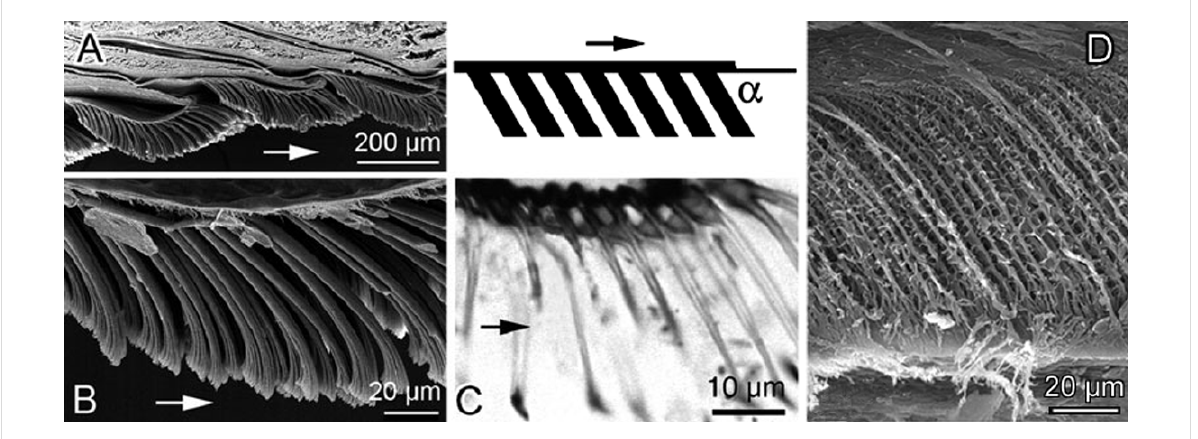
Figure 7: Convergent evolution of an asymmetry of micro- and nanostructural features (scheme is given in the inset) in animal attachment pads, leading to functional anisotropy upon contact. Longitudinal sections of pads are visualised in SEM (A,B,D) and in light microscope (C). (A,B) Tokay Gekko gecko (hairy pad). (C) Fly Calliphora vicina (hairy pad). (D) Bush cricket Tettigonia viridissima (smooth pad). The arrows indicate distal direc- tions in all pads. Figure 7A–C is from [241] and was adapted by permission from Springer Nature from “Biological fibrillar adhesives: functional princi- ples and biomimetic applications. In: Handbook of Adhesion Technology” by S. N. Gorb, Copyright 2011 Springer Nature. This content is not subject to CC BY 4.0. Figure 7D was adapted from [129] with permission from The Royal Society (U.K.), from Proc. R. Soc. B, S. N. Gorb, vol. 267, issue